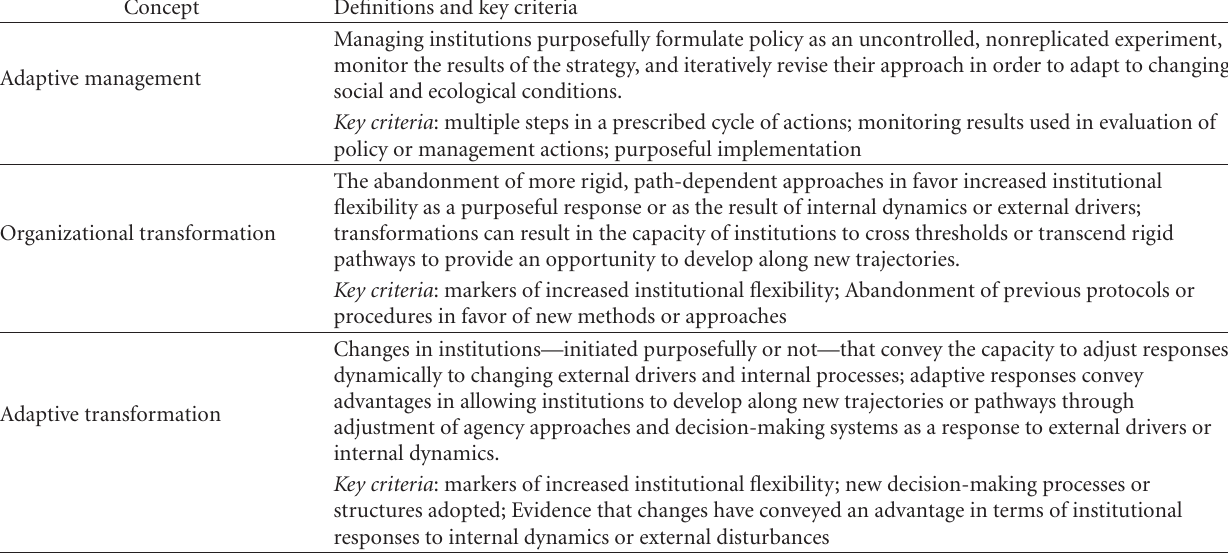
Table 7: Concepts and definitions in ecosystem-based management and institutional